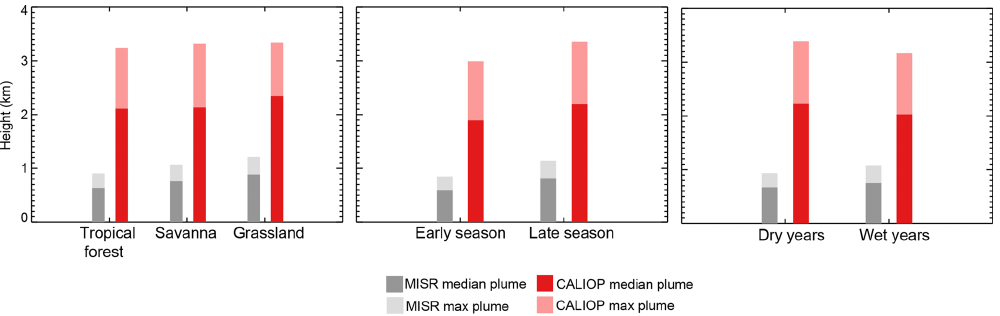
Figure 10. Average CALIOP and MISR plume heights per biome, time of the season and dry or wet years. The burning season is divided into early (July–August–September) and later (October–November) periods, and dry years (2007, 2010) and wet years (2006, 2008, 2009, 2011). Bars represent MISR plume heights (grey) and combined daytime and night-time CALIOP plume heights